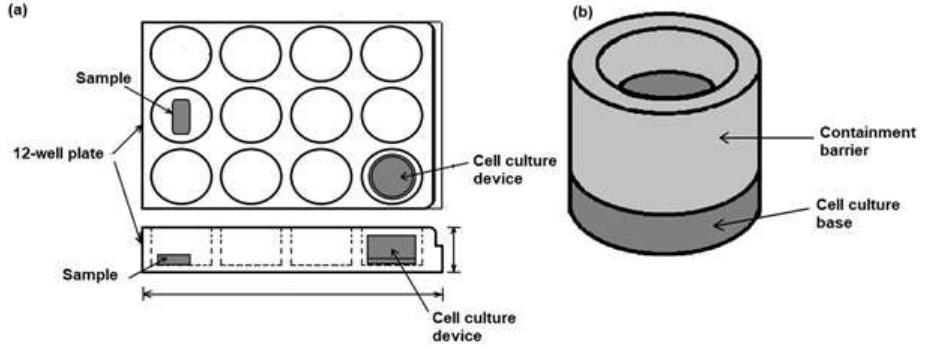
Figure 2. Schematic representation of the direct cell culture device (DCD) used for the in vitro experiments. ( a ) Colocation of the DCD for the cell culture and ( b ) configuration of the